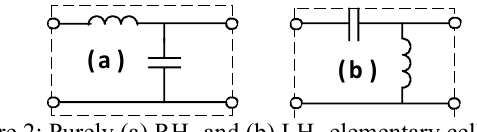
Figure 2: Purely (a) RH- and (b) LH- elementary